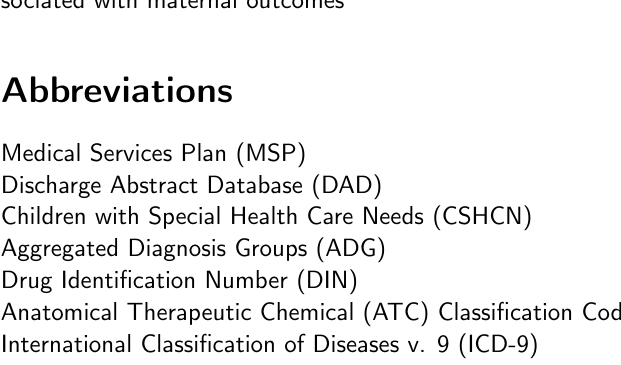
Supplementary Table 1. Description of child and maternal health outcomes measured Supplementary Table 2. Full regression results. Estimates as- sociated with maternal